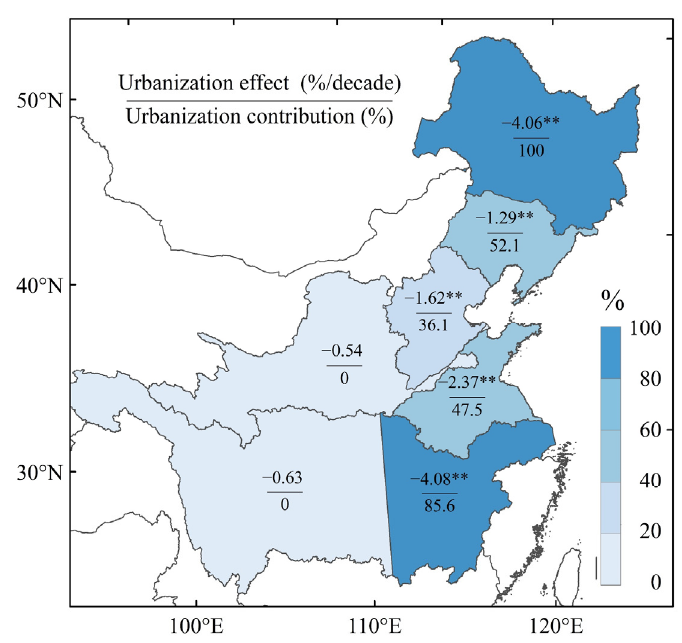
Figure 4. The urbanization effects and contributions of the large river basins for period 1961–2017 (values on map represent urbanization effect and contribution; * and ** denote that the trend was statistically significant at 0.05 and 0.01 level).